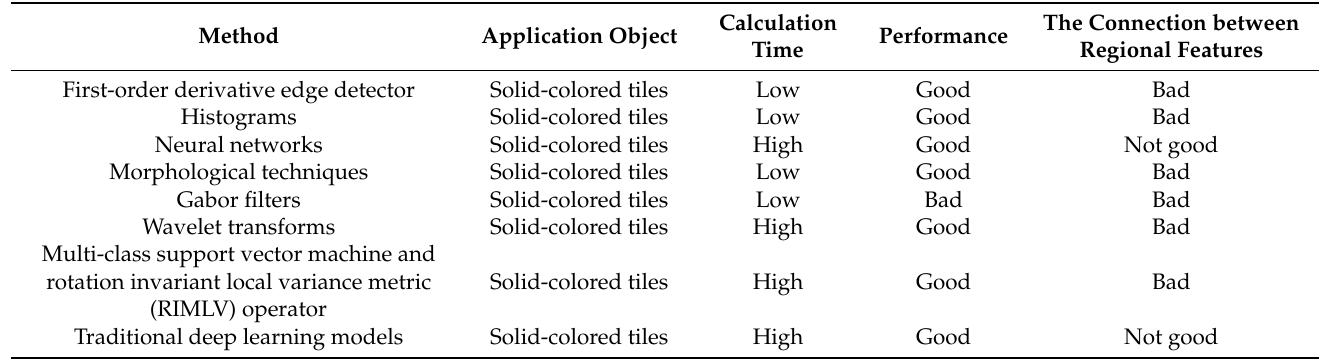
Table 1. The characteristics of different methods in tile block defect